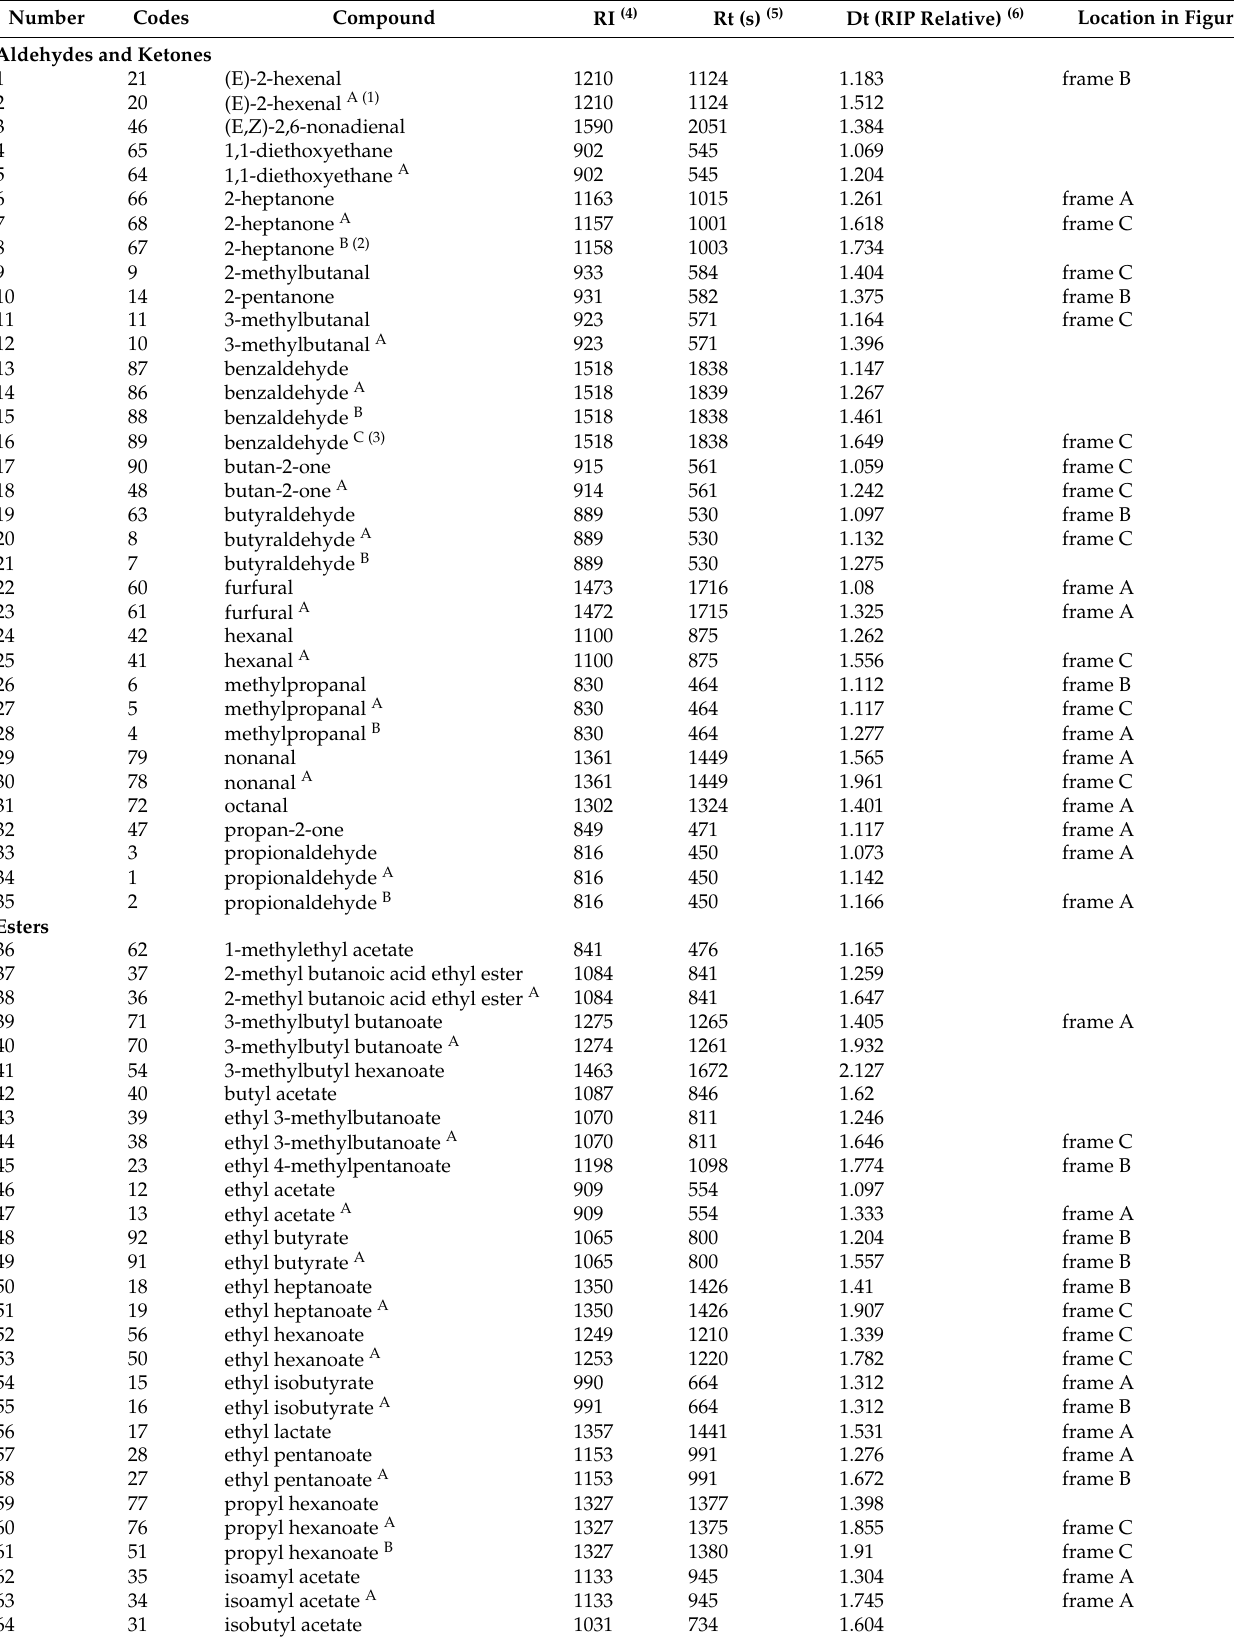
Table 1. Information about the identified volatiles in Baijiu samples detected by